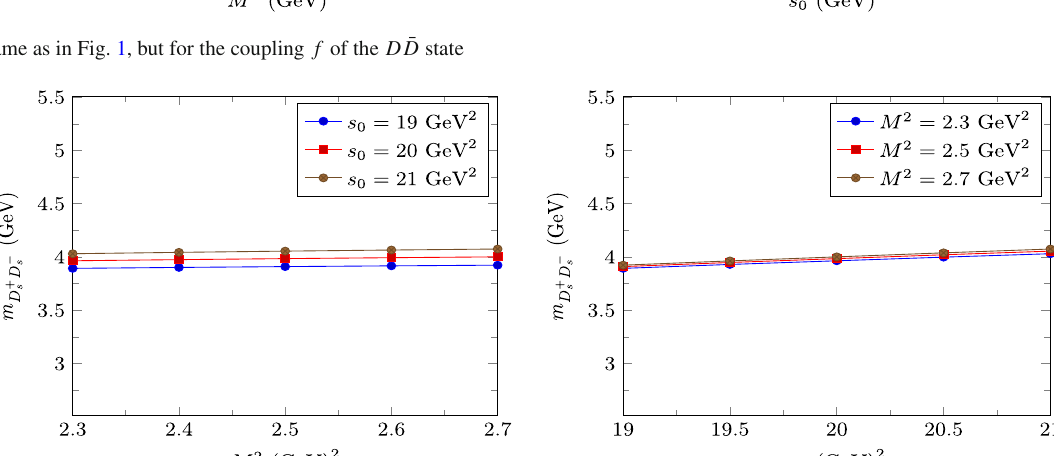
this range. After providing PC in an appropriate range, one can extract the mass and decay constant values for the cor- responding state. Our results for masses and decay constants ¯ D − D and D + states read as of D s s